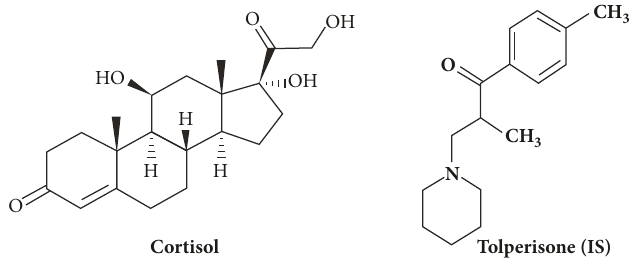
Figure 1: Chemical structures of cortisol and tolperisone